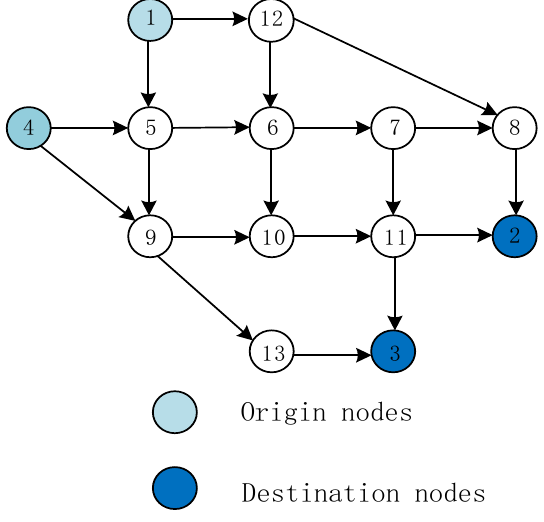
Figure 2. Nguyen-Dupius network.